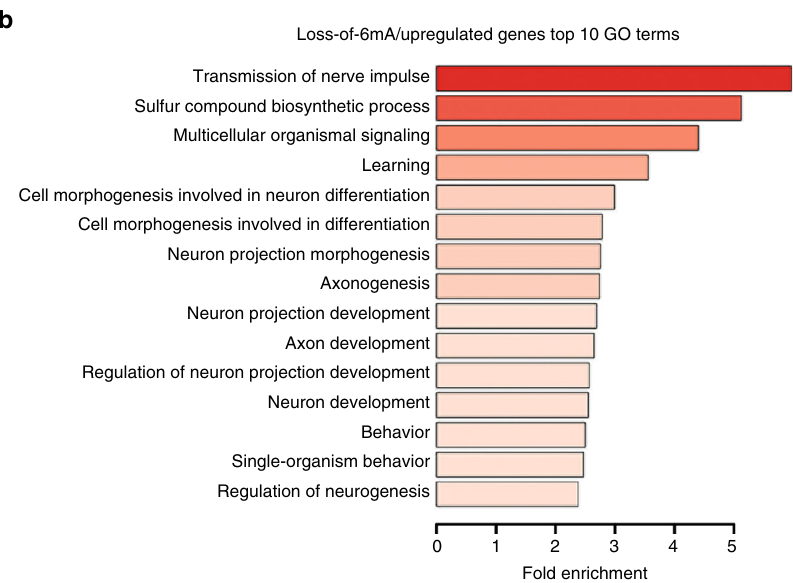
Fig. 4 N (6)-methyladenine negatively correlates with neuronal gene expression in response to stress. a Genes with signi fi cant loss-of-6mA and increased expression upon stress are indicated. The log2 fold changes (Stressed:Control) of both 6mA and transcription are illustrated by Heatmap. Red plots (fold change > 1) indicate transcription upregulation upon stress, whereas blue plots (fold change < 1) indicate loss-of-6mA on the same genes upon stress. b Genes in a were enriched in pathways related to neuronal functions, neurogenesis and behavior control. Fold enrichment of each GO term are indicated by the x -axis and bar color. c Circos plot to indicate the relationship between genes and GO terms. Cross-examination of GO analyses suggested that a substantial number of upregulated genes with loss-of-6mA related to behavior were also enriched in other biological functions such as learning and neuron projection development. Log2 fold changes of gene expression were indicated as colored